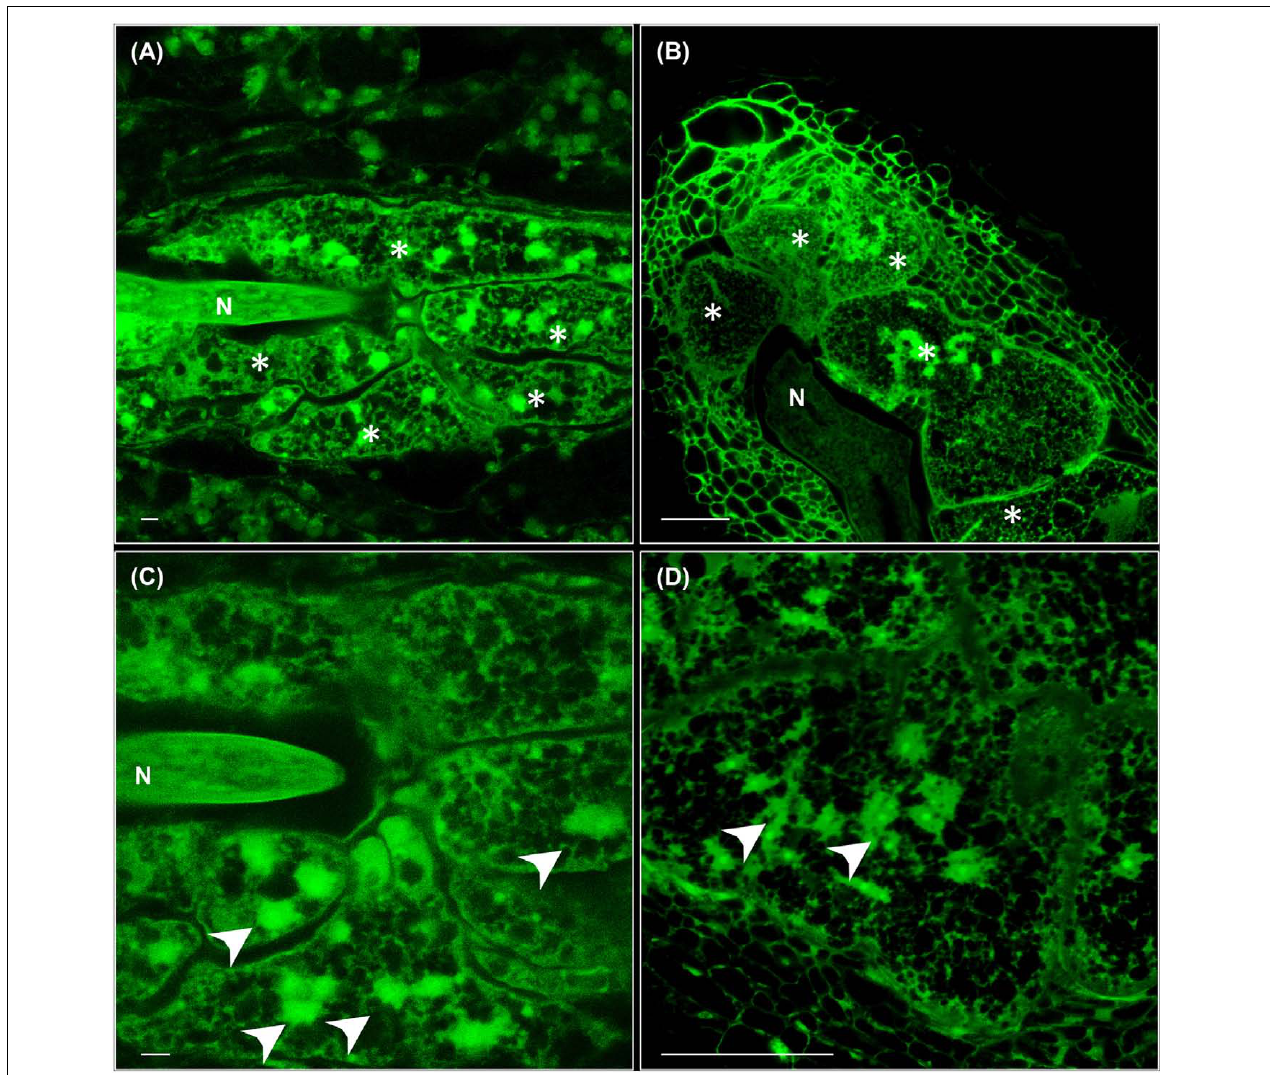
FIGURE 1 | Cytological features of feeding sites and giant cells (GCs) formed in leaves and in vascular root tissues by Meloidogyne javanica . (A) A representative feeding site formed in a secondary vein of an Arabidopsis leaf at medium-late infection stage (30–40 days after inoculation). The anterior part of the nematode body is clearly in the middle of 4–5 GCs that are irregular in shape with a large size. (B) A representative feeding site formed in the roots of Arabidopsis at medium-late infection stage (21 days after infection). A large GC size with reticulated cytosols and many irregular, some clustered, nuclei are observed similarly either in GCs formed in leaves (C) or roots (D) . Scale bars: 50 µ m. N, nematode. Asterisks, GCs. Arrow heads point to some